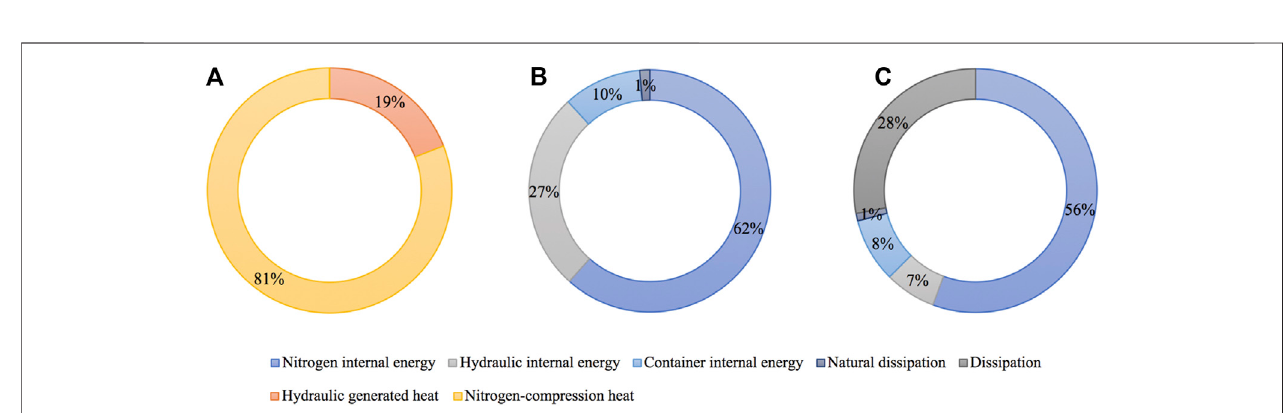
FIGURE 11 | Ratios of the heat source and heat transfer or storage of IHESS: (A) Heat source. (B) Heat storage. (C) Dissipated heat storage.